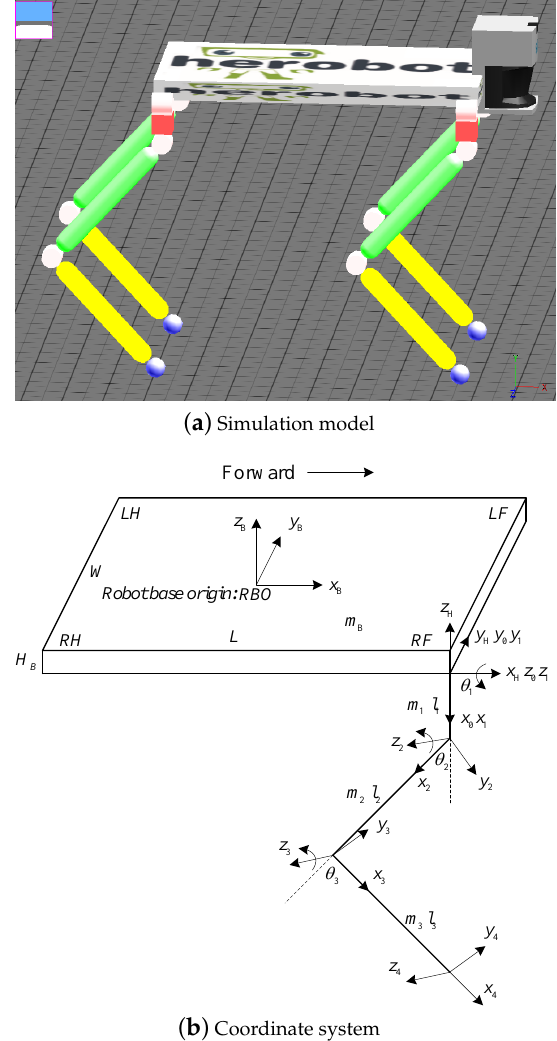
Figure 1. The simulation model and coordinate system of the quadruped